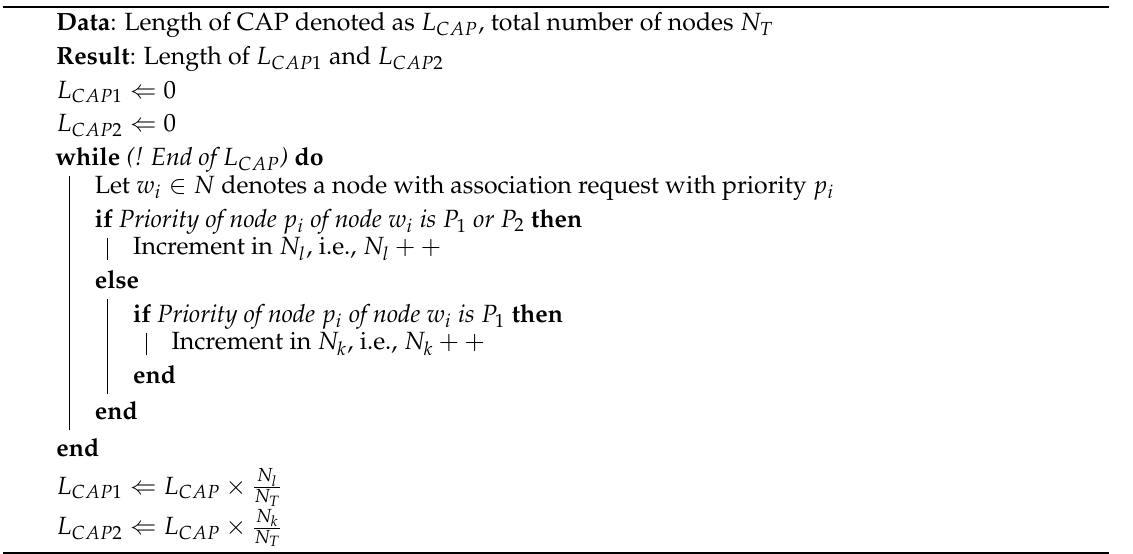
Algorithm 1: Computes L CAP 1 and L CAP 2 based on traffic